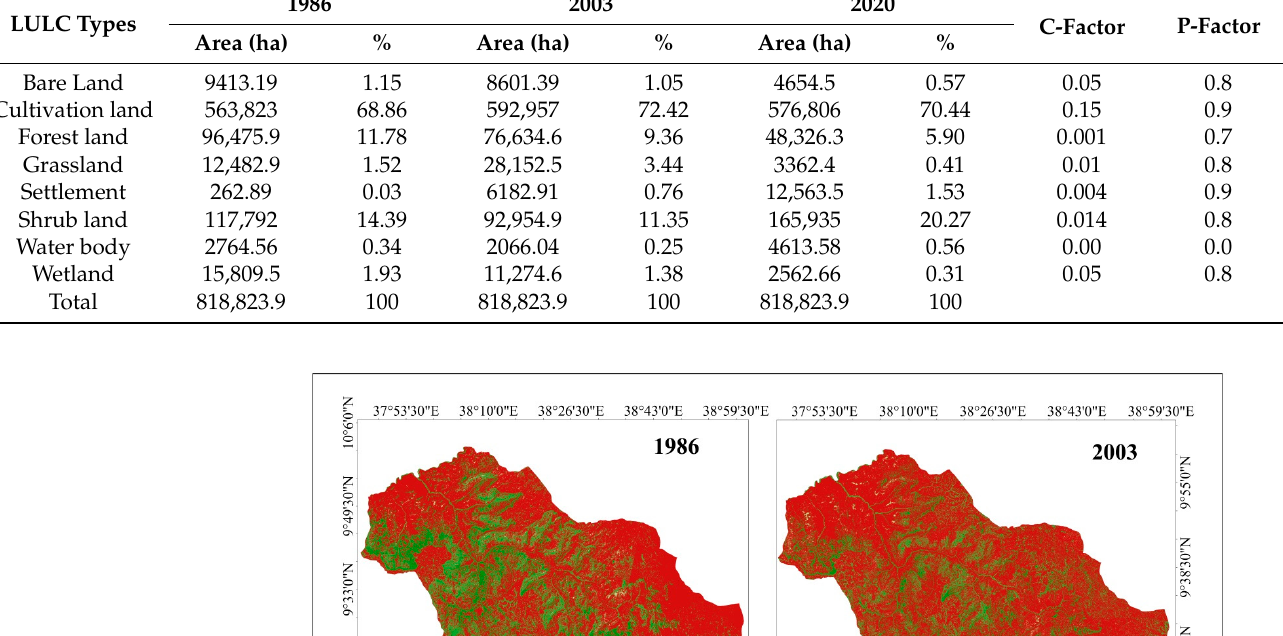
Table 4. The LULC types in Muger sub-basin and the corresponding C and P factors.